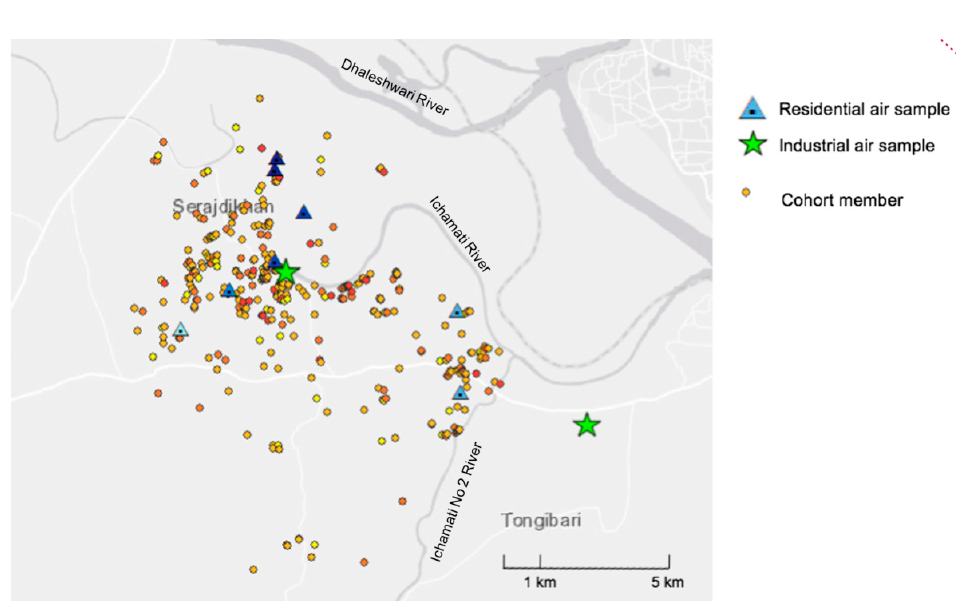
Figure 1. Geographical distribution of participants and air sampling sites.